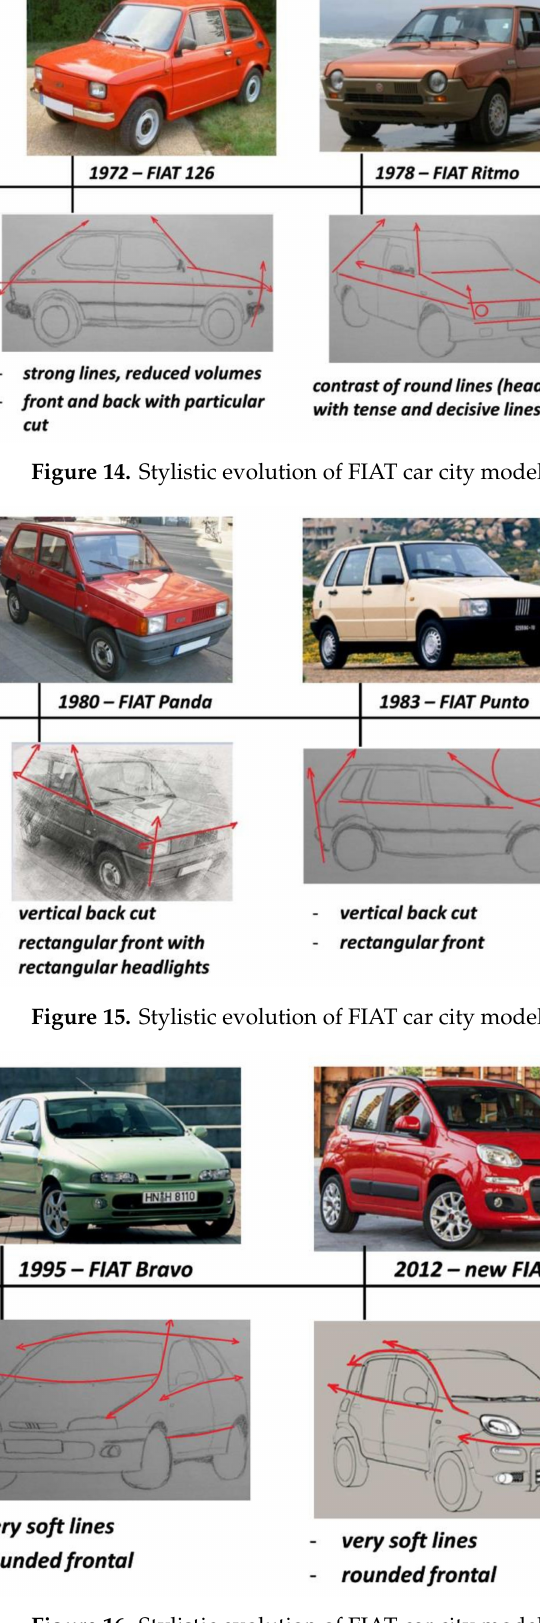
Figure 16. Stylistic evolution of FIAT car city